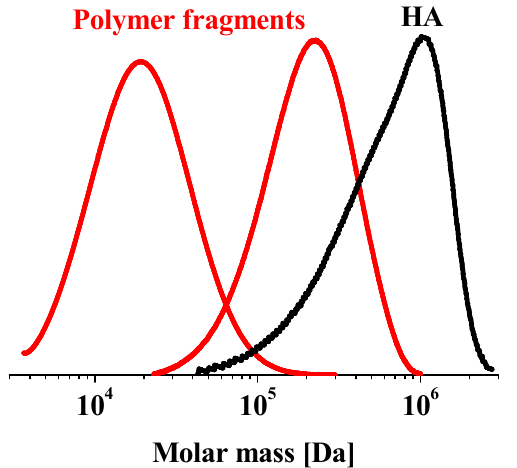
Figure 2. Comparison of the molar mass distribution of the megadalton HA sample and those ones degraded in situ under aerobic condition by action of AscH − and copper ions. Adapted from [51], published by Elsevier,